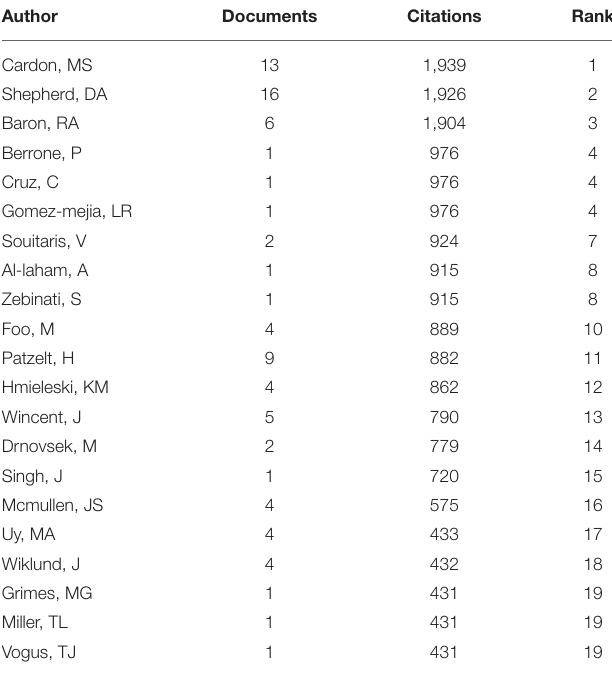
TABLE 3 | Top 20 cited authors (including